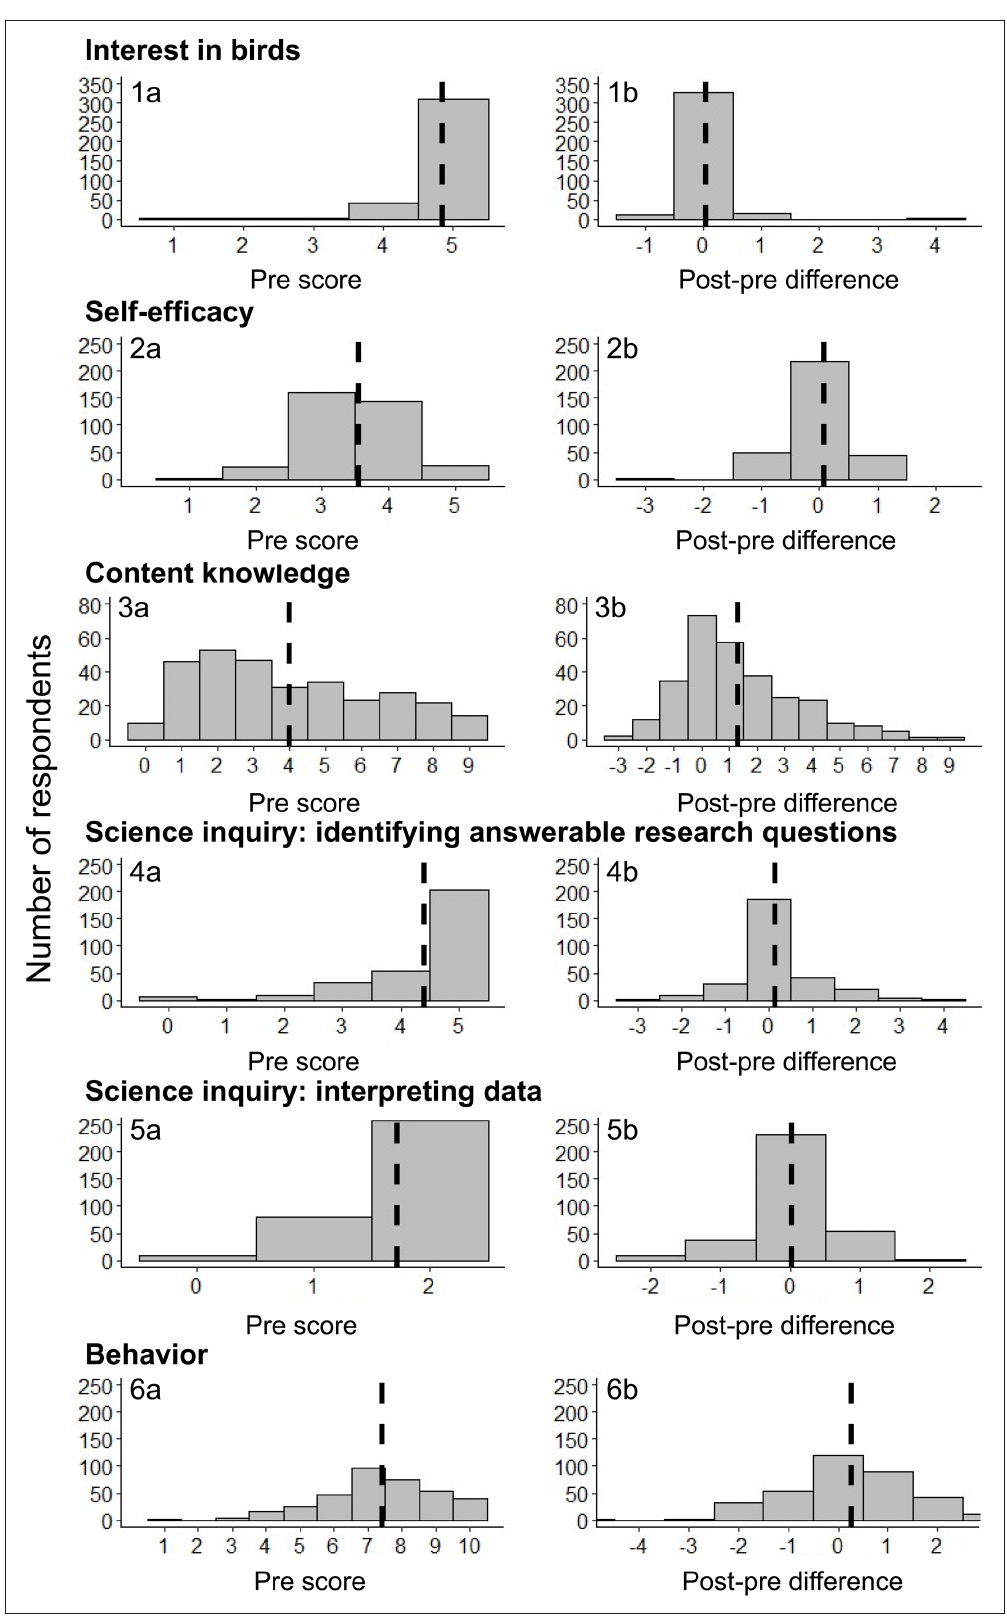
Figure 2 For each dependent variable with a pre-post difference (1–6), distributions of (a) pre-survey scores and (b) post-pre differences in scores with the mean shown as a dashed line. Note that the range of the horizontal axes and vertical axes differ, and that this figure shows raw data without controlling for other variables included in the statistical